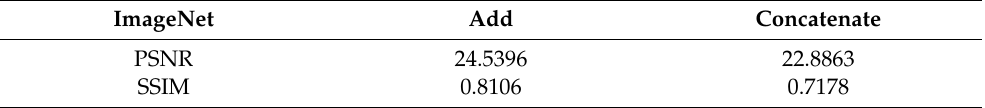
Table 8. Test results of the ImageNet dataset. Using aggregation and concatenate connection between encoder and decoder.